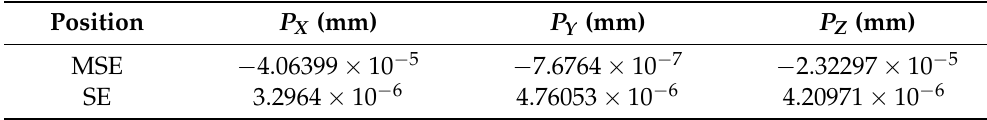
Table 11. Mean Squared Error (MSE) and Standard Error (SE) of the Forward Kinematics— Second